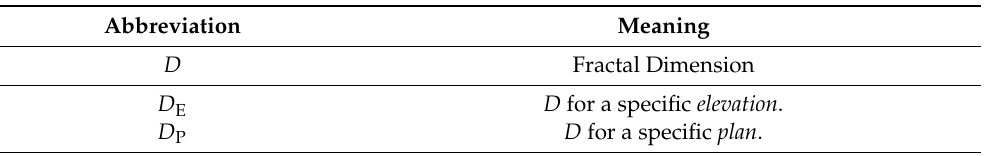
Table 1. Summary of mathematical notations and definitions for fractal dimension analysis of a building or a set of